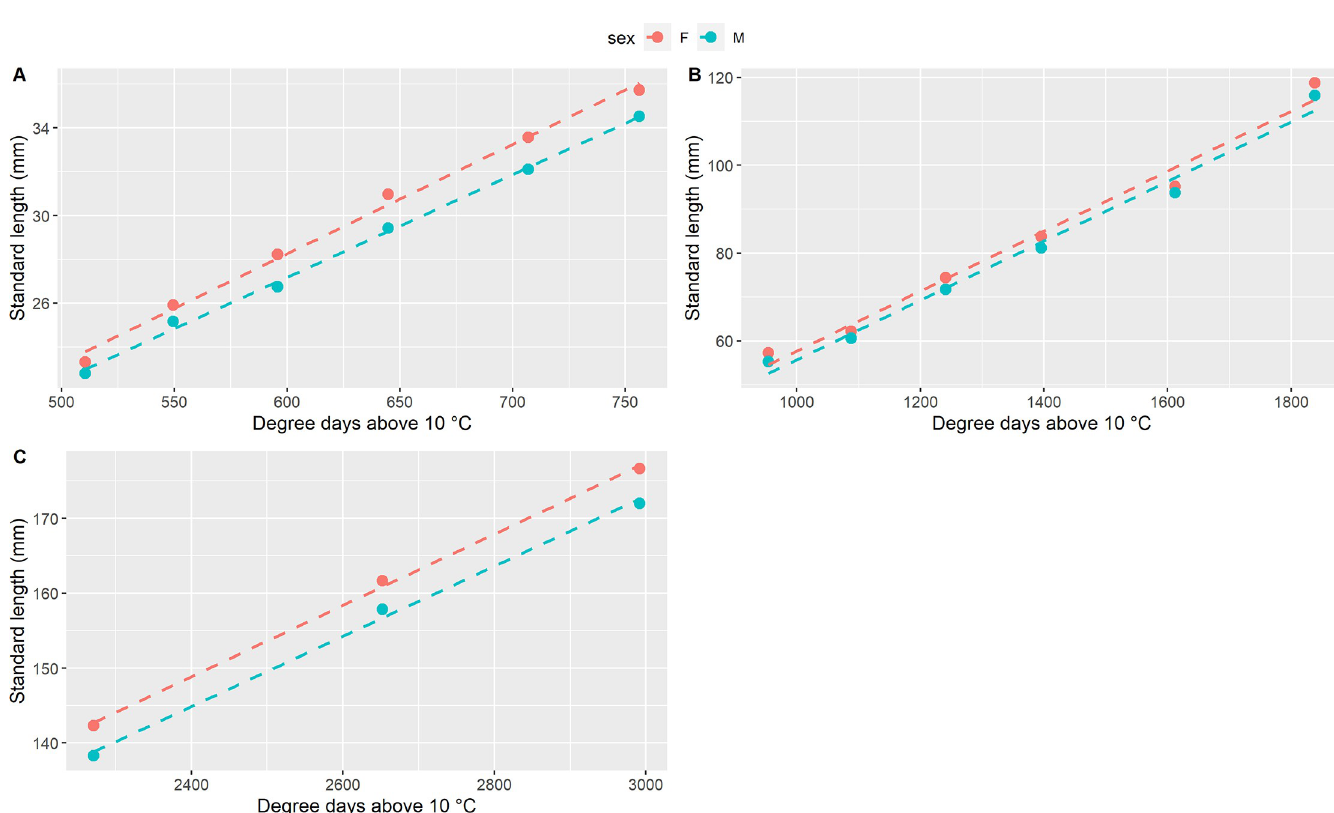
Fig 1. Growth curve for standard length. Standard length growth curve for females (F) and males (M) in the three growth periods: A) from 83 to 117 dph (510 to 756 degree days); B) from 137 to 223 dph (756 to 1838 degree days); C) from 265 to 335 dph (2271 to 2992 degree